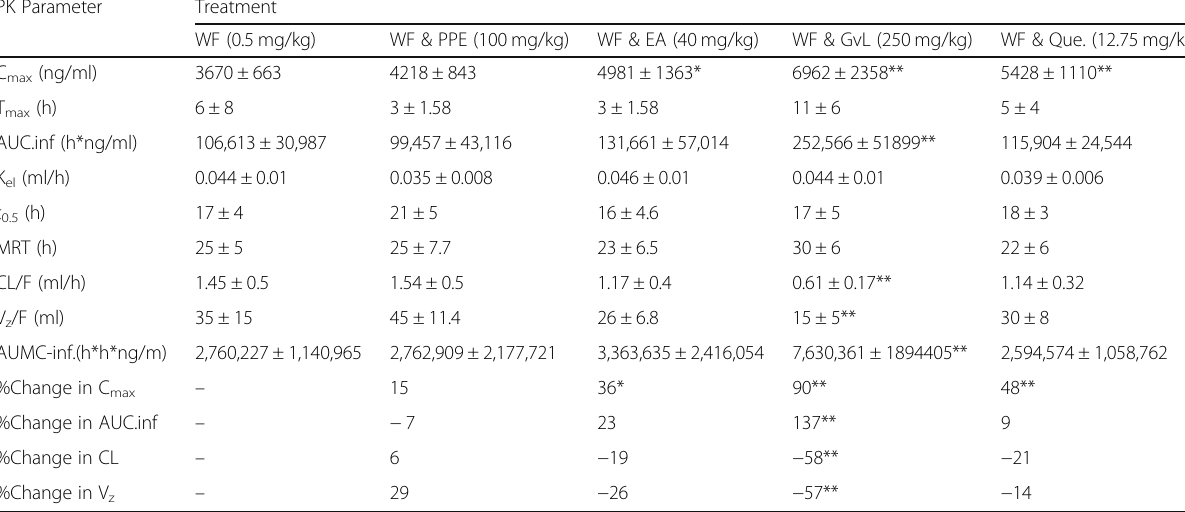
Table 3 Pharmacokinetic parameters (PK) of warfarin alone (0.5 mg/kg) or in combination with the investigated natural products and their quality